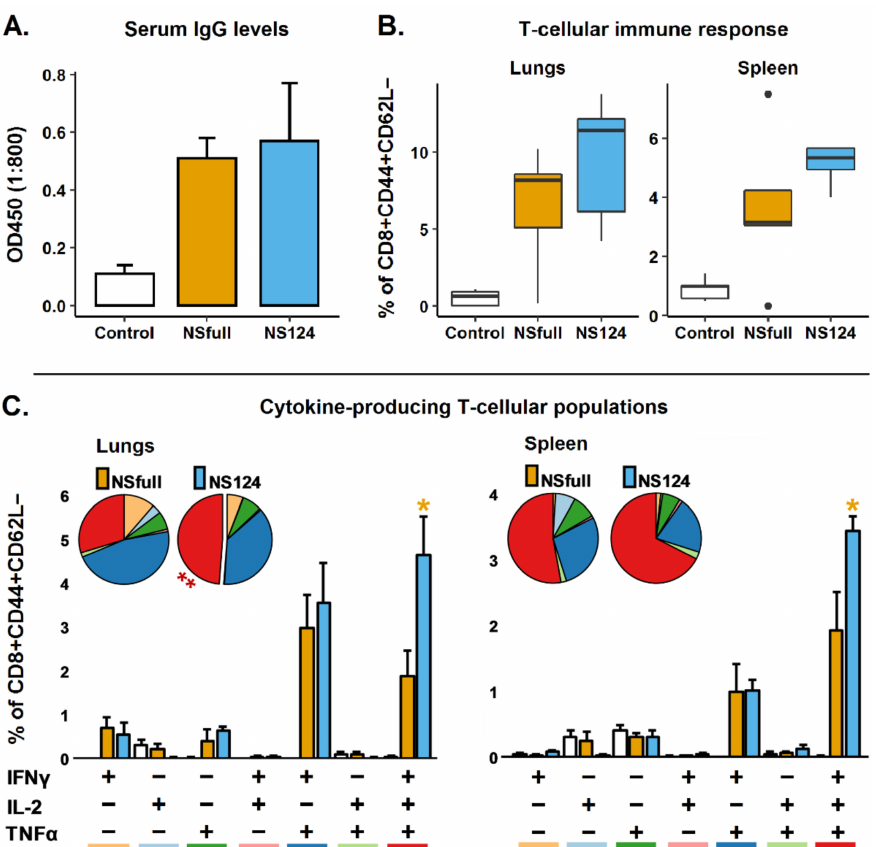
Figure 1. Humoral and CD8 + T-cellular immune response to intranasal immunization with A/PR8/NSfull or A/PR8/NS124 influenza strains. ( A ). Total level of influenza-specific IgG de- termined with ELISA. The histograms represent the optical density of the serum samples di- luted 1:800 (mean ± SD, n = 8). ( B ). Total percentage of cytokine-producing effector memory CD8 + CD44 + CD62L − T-lymphocytes after 6 h of in vitro lung or spleen cells stimulation with the NP 366-374 peptide 32 d.p.im. ( C ). Histograms represent the percentage of different populations of cytokine-producing T-cells in the total effector memory (EM) CD8 + CD44 + CD62L − T-lymphocytes population. Pie charts represent the percentage of cells producing any combination of IFN γ , IL2, or TNF α cytokines in the total cytokine-producing CD8 + EM T-cell subset. Color bars under histogram mark different cytokine-producing populations and correspond to the pie chart color scheme. Groups were compared using ANOVA followed by Tukey’s post-hoc test (*: p < 0.05, **: p < 0.001, n =